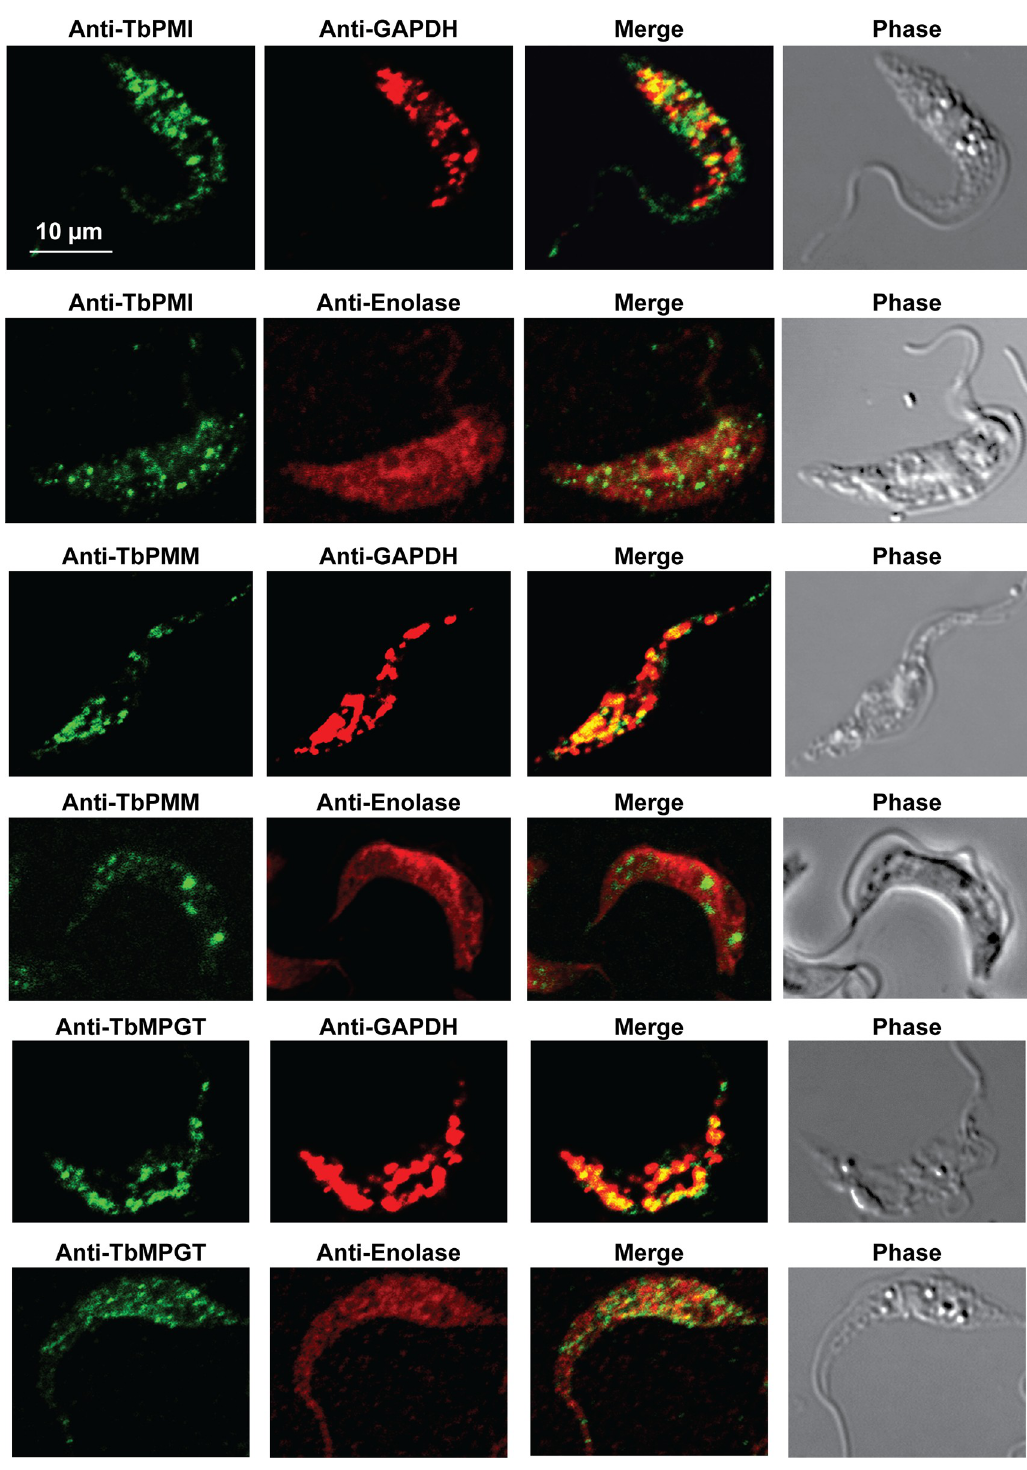
Fig 3. Immunofluorescence microscopy localisation of GDP-Man biosynthetic enzymes in procyclic form T . brucei . Enzymes of GDP-Man biosynthesis were localised with mono-specific mouse antibodies (green channels). Authentic glycosome and cytosol markers TbGAPDH and TbEnolase, respectively, were localised with specific rabbit antisera (red channels). Merged green and red channels and phase-contrast images are also shown.